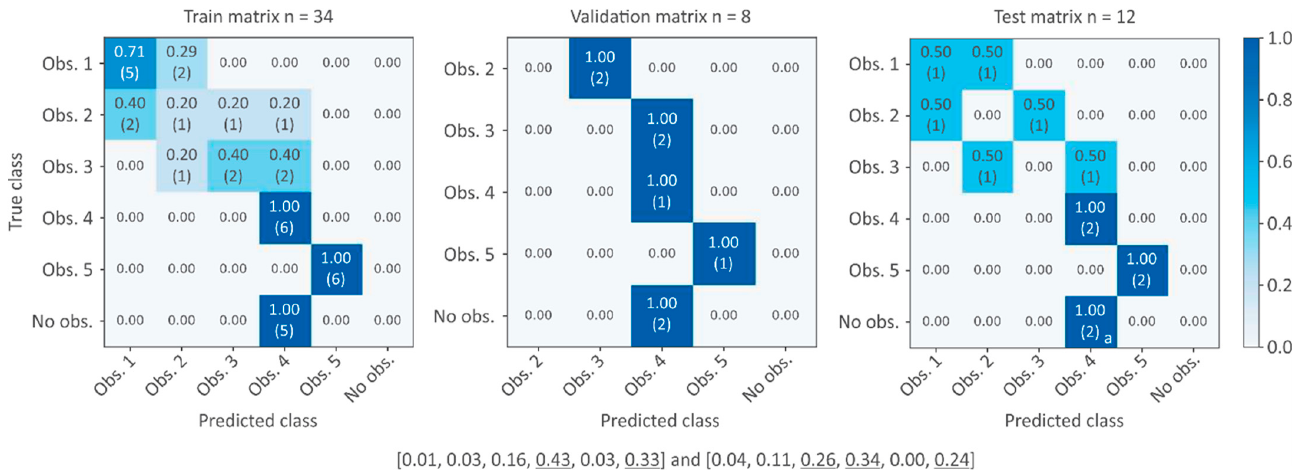
Figure 7. Confusion matrix for training, validation, and test datasets using three nodes. Misclassifications in the test dataset correspond to obstruction in the second cross-wall notch (a), obstruction in third cross-wall orifice (b), obstruction in the fourth cross-wall notch (c), and obstruction in the fourth cross-wall orifice (d) (class probabilities of misclassifications are indicated at the bottom of the picture).